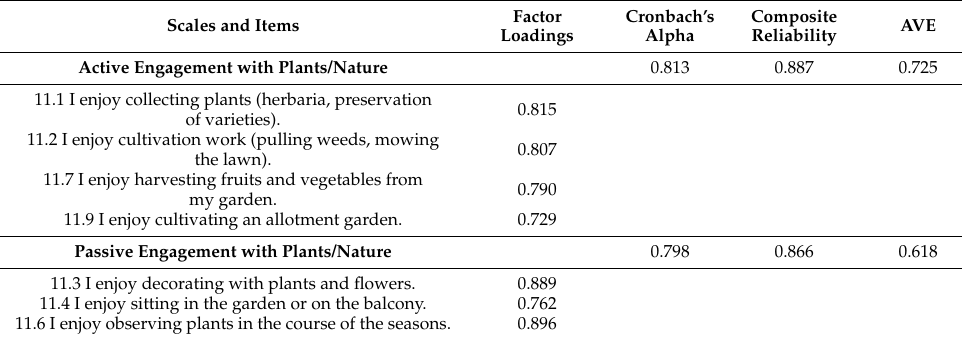
Table 2. Scale Loadings, Reliabilities, and Convergent